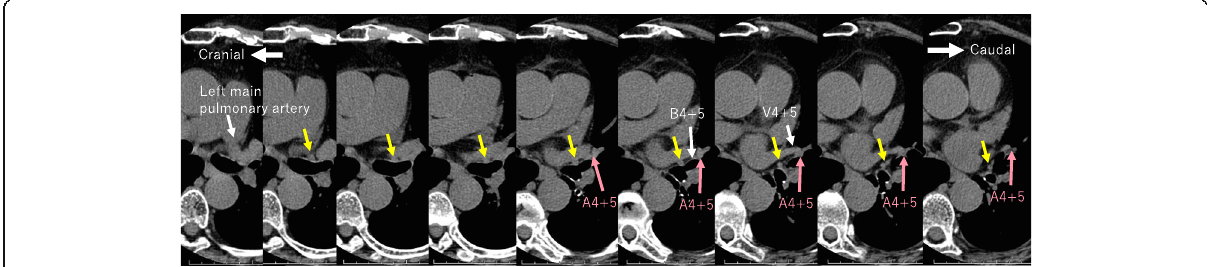
Fig. 4 Chest-computed tomography (mediastinal window setting). It shows a pulmonary branch from the left main pulmonary artery to S8 (yellow arrow). It is different from mediastinal A4+5 (pink arrow). It is between the left superior pulmonary vein and the left upper lobe bronchus Table 1 Abnormal branch of the left pulmonary artery to the lower lobe: a review of the literature Report